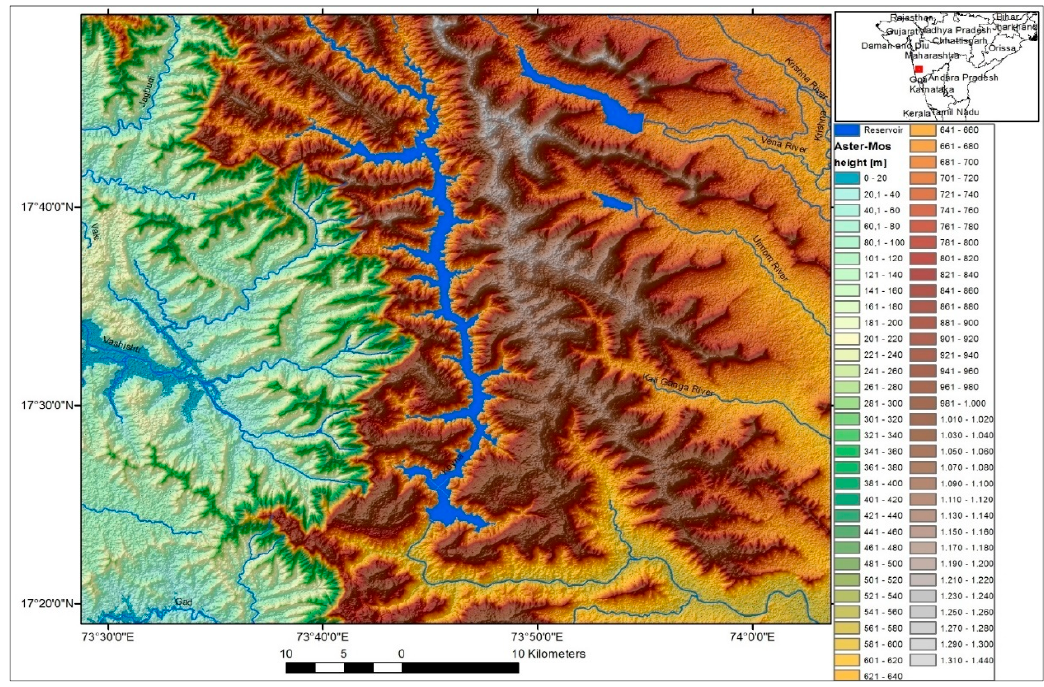
Figure 3. Height level map.